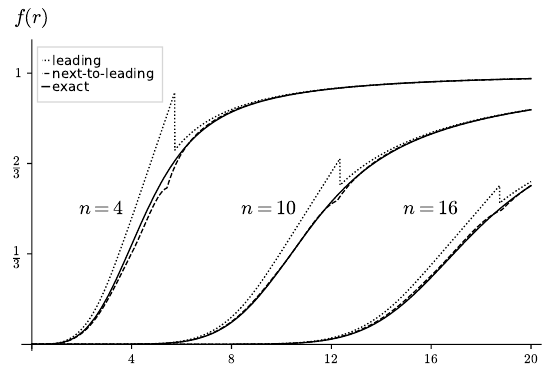
Figure 8 . The numerical solution of the exact vortex equations for a neutral scalar field f ( r ) (solid line), the leading asymptotic solution eq. (3.9) (dotted line), and the next-to-leading approximation (dashed line) for different n